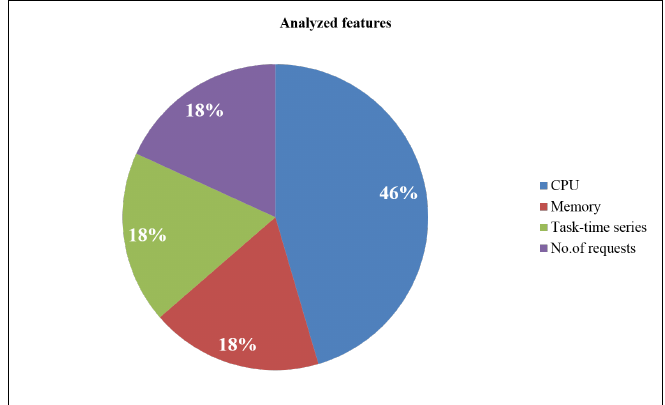
Figure 6. Representation of the features analyzed.